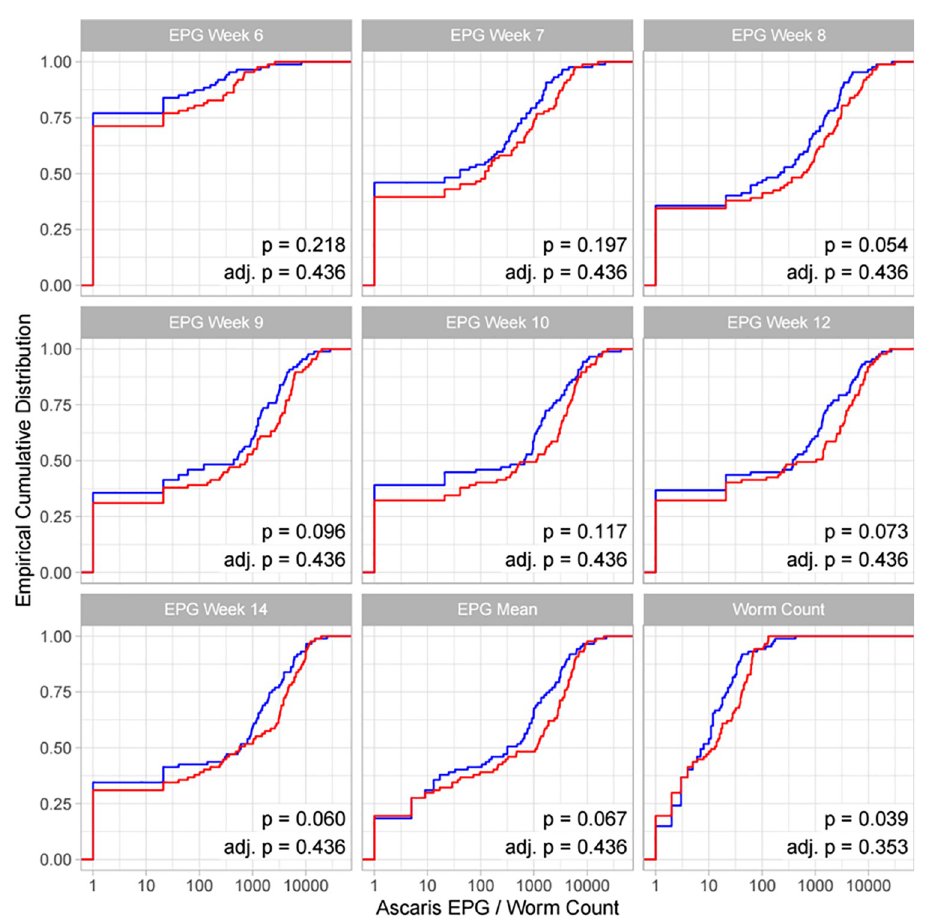
Fig 2. Empirical cumulative distribution function plots of Ascaris suum EPG at each time point (EPG week 6–14) and mean EPG throughout time course (EPG mean) for low weight gain animals (red) compared to high weight gain animals (blue) grouped by pig weight gains at weeks 0–14 (n = 174). p-values based on Wilcoxon signed rank tests are given in addition to the same p-values adjusted according to Holm’s method (Holm, 1979)